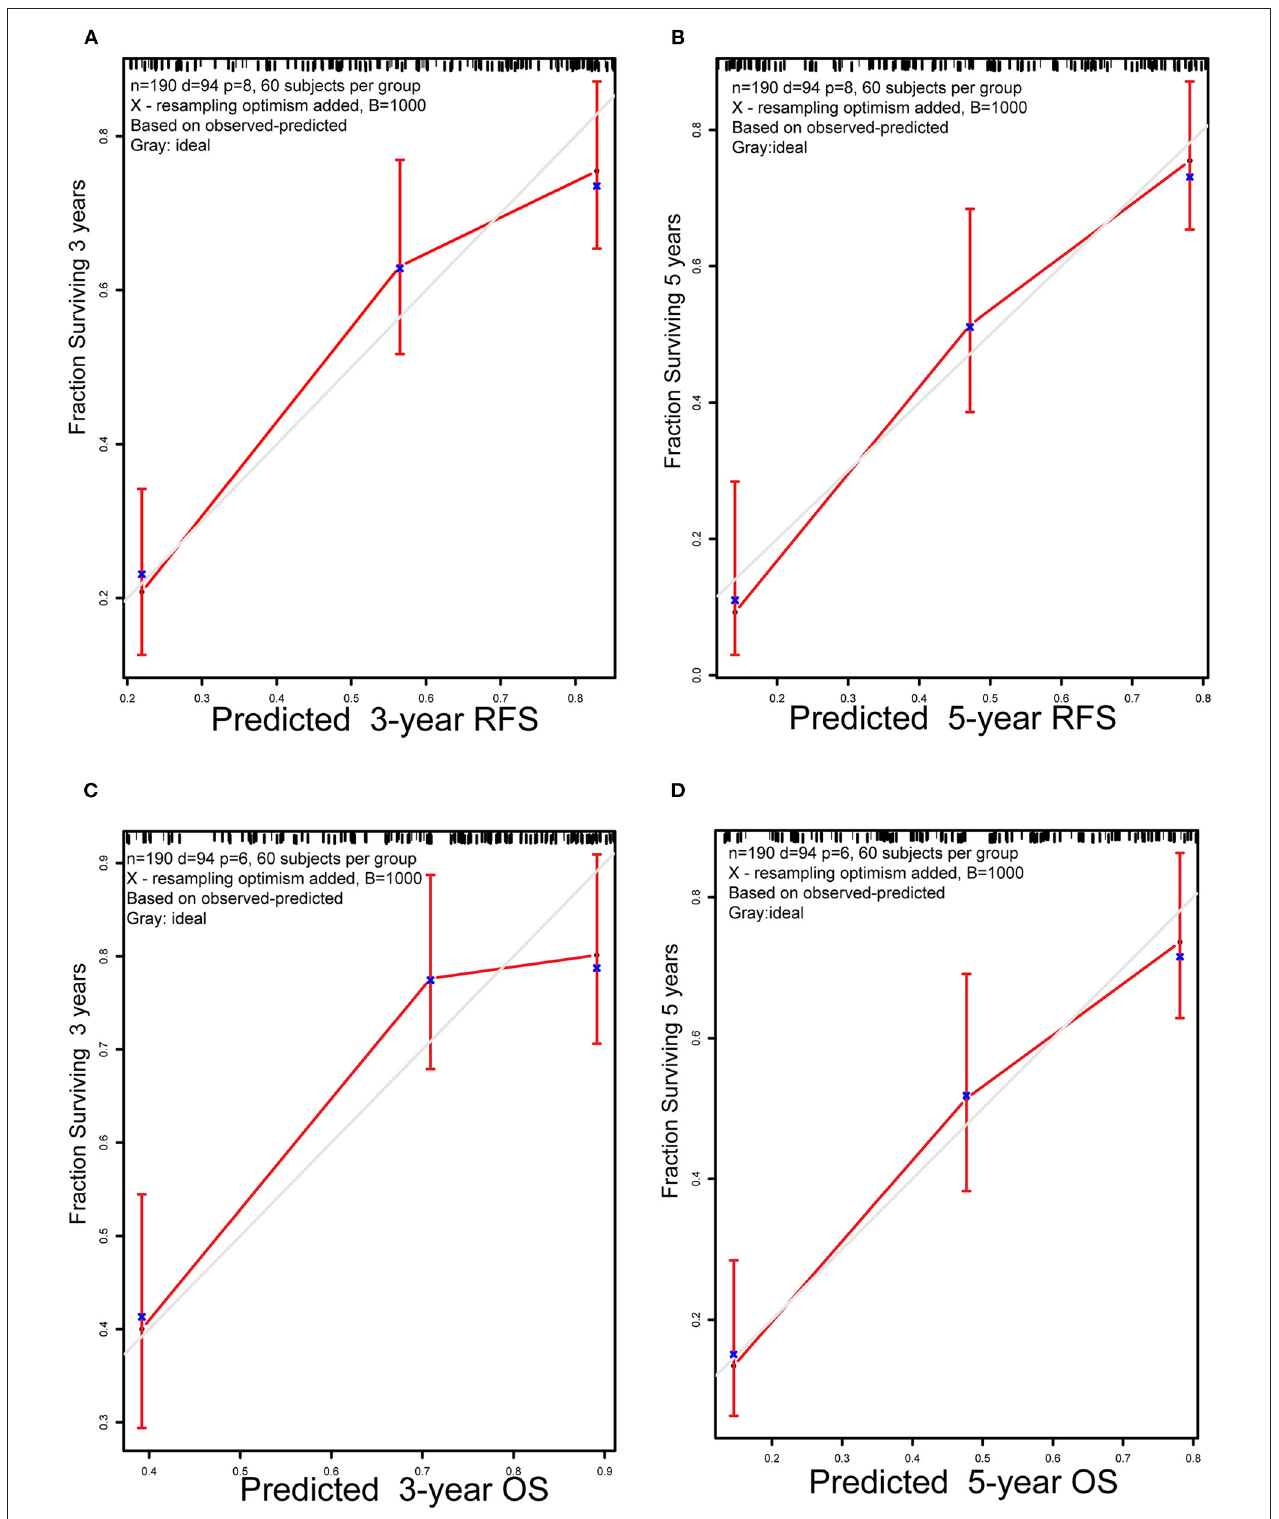
FIGURE 3 | Calibration plots. (A) 3-year and (B) 5-year RFS nomogram calibration plots; (C) 3-year and (D) 5-year OS nomogram calibration plots; RFS, replase-free survival; OS: overall survival.